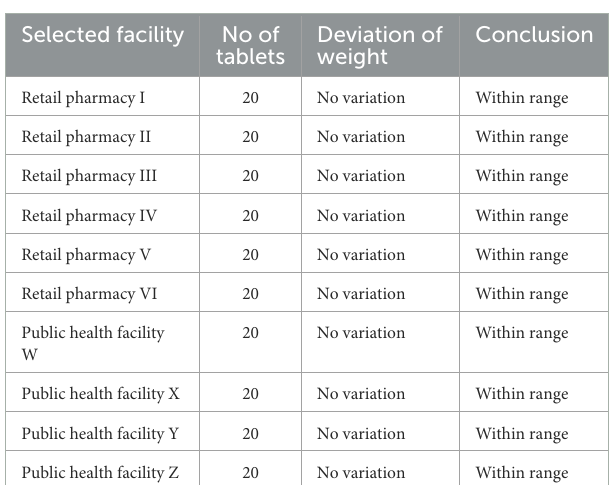
TABLE 4 Uniformity of weight in FDCs tablets sampled from different